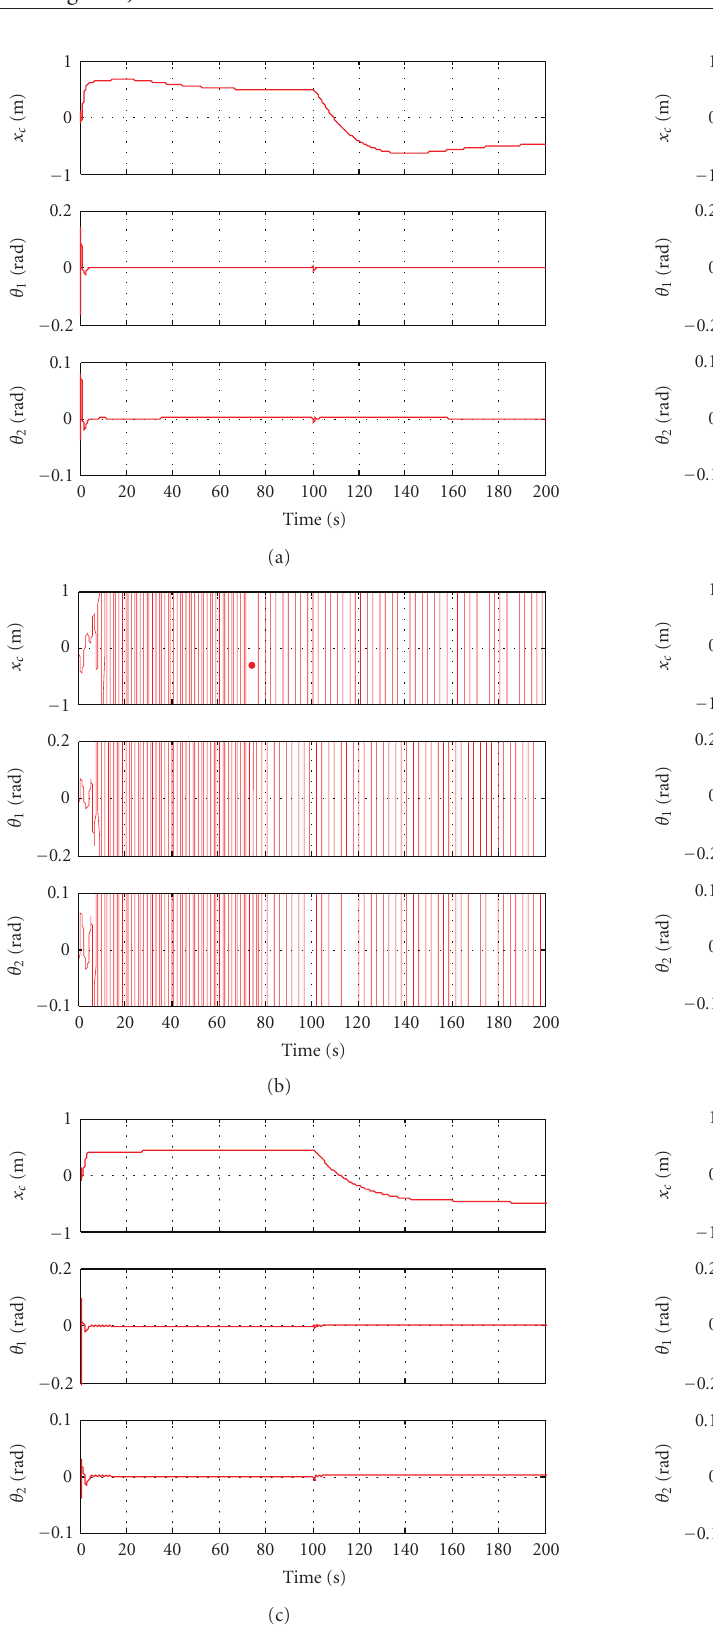
Figure 10: System responses of all controllers under multiple sensor fault condition with modelling uncertainty. (a) —- FTCS, (b) ... H ∞ controller, and (c) - - - μ